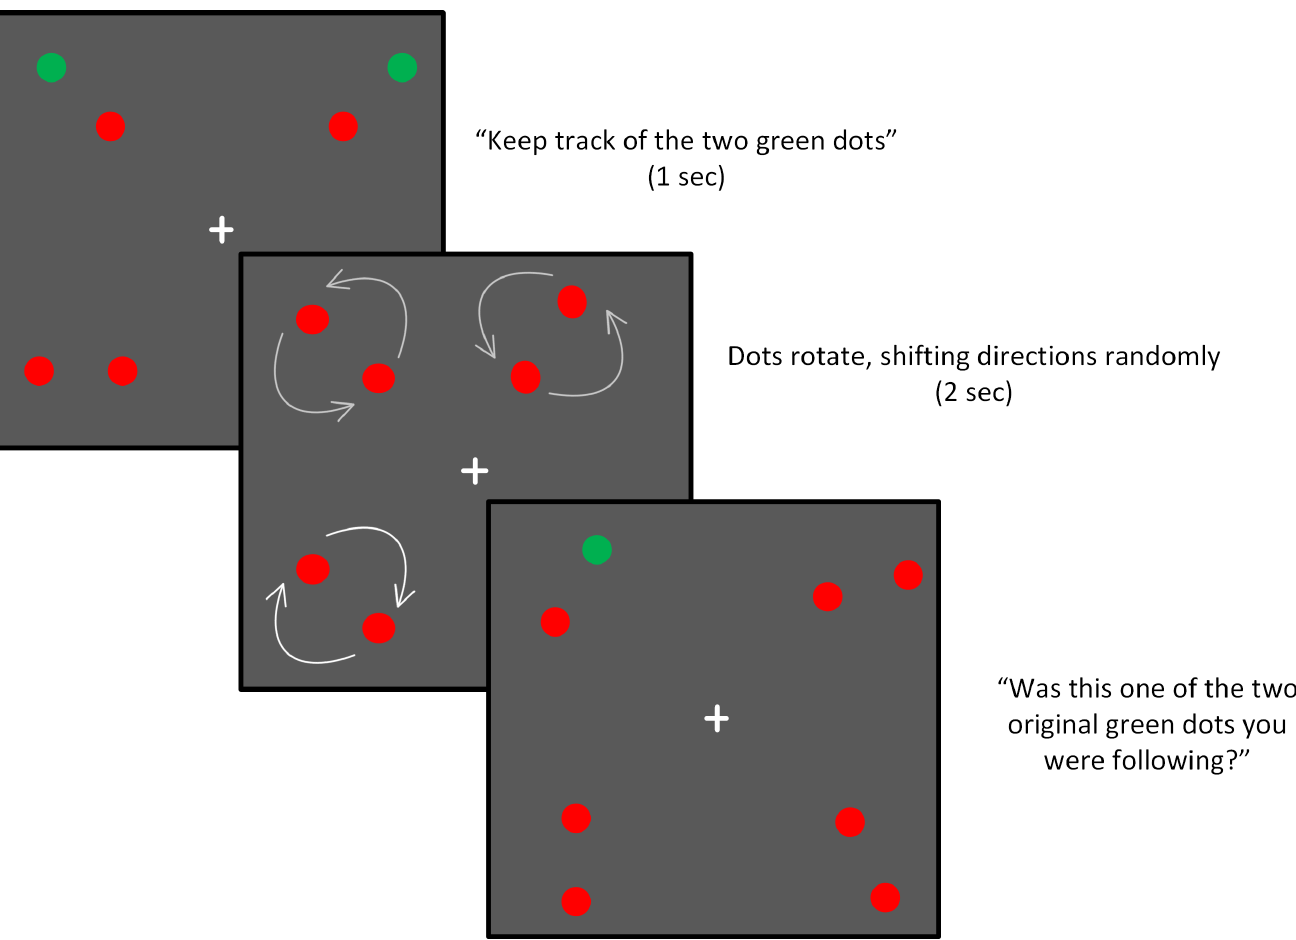
Fig 4. Stimuli and task for Experiment 2. In this experiment, dots rotated at a constant, moderate speed. The critical variable was the spatial arrangement of the two targets, which were placed in either the same hemifield (SH) or opposite hemifield (OH) as each other.